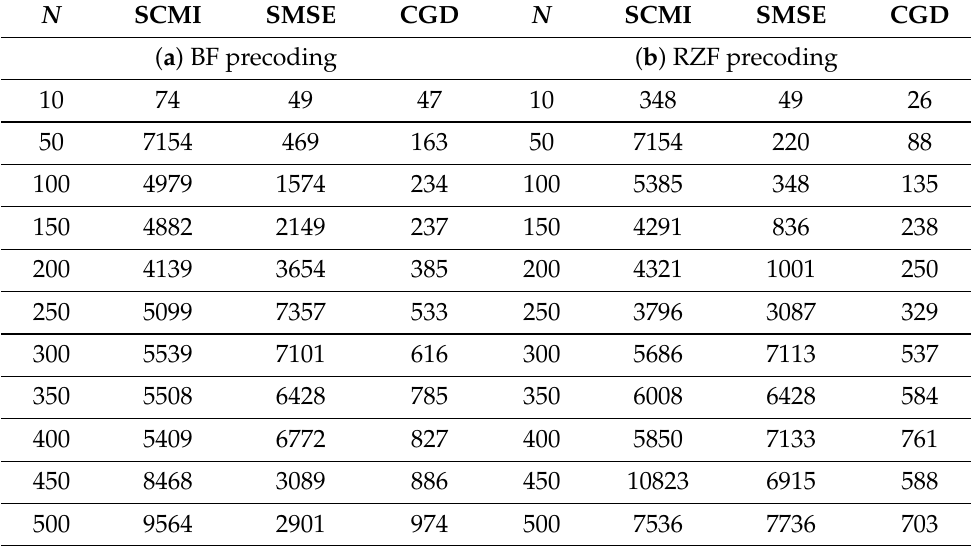
Table 7. The number of iterations per each training sequence algorithm required to converge with respect to the number of BS antennas N for the pilot length in BF and RZF precoding in the OR model with ω = 5 ◦ , D = 1/2, T = 100 symbols, ρ d = 10 dB and K = 12